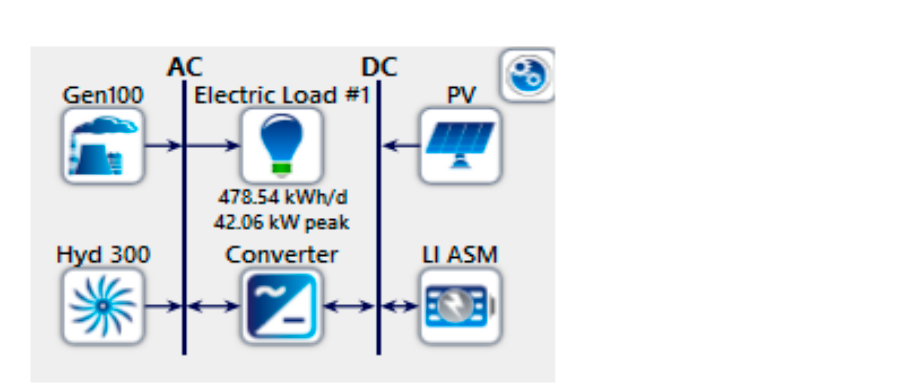
Figure 13. Daily and seasonal profiles for solar Energy at KHMG.